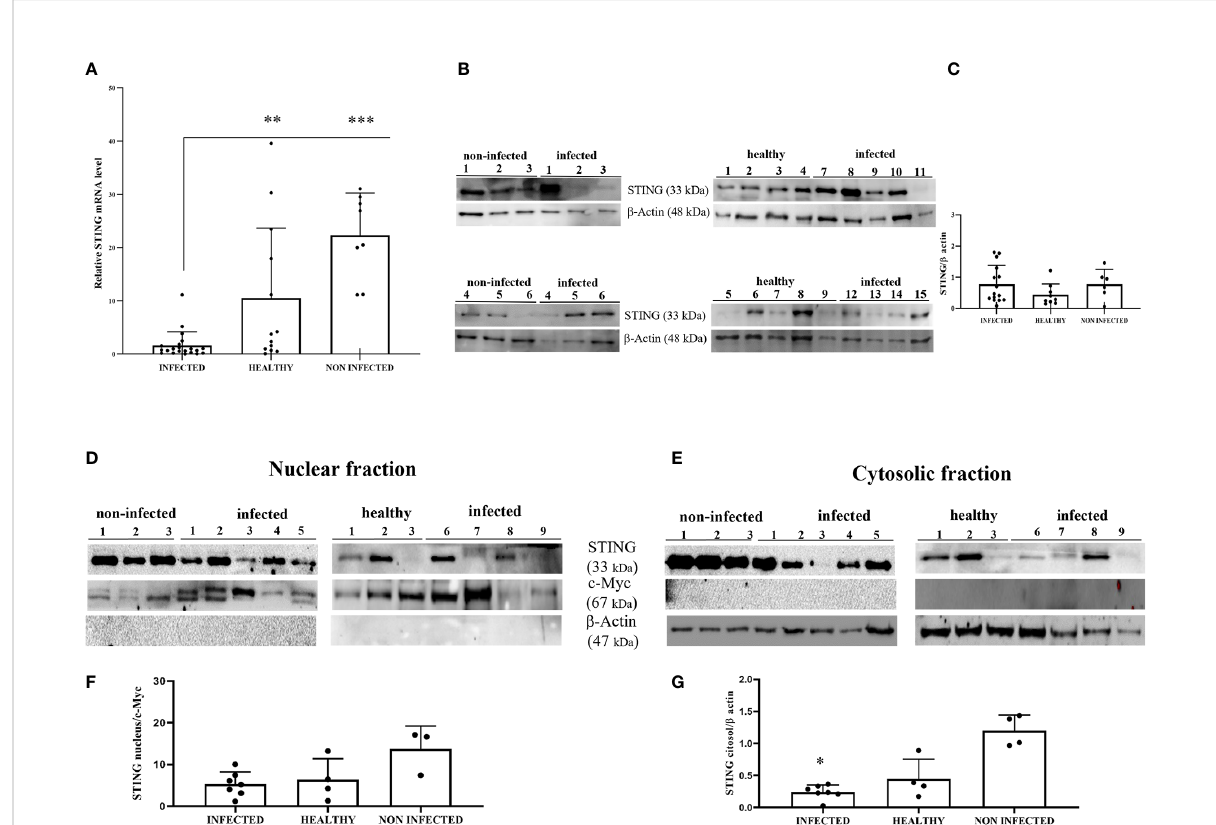
FIGURE 3 (A) RT-qPCR analysis of STING mRNA levels in infected, non-infected, and healthy bladder samples, respectively. STING mRNA expression was signi fi cantly reduced in infected bladder compared with both non-infected and healthy bladder samples (***p ≤ 0.001; **p ≤ 0.01);. (B) Western blot analysis of STING in infected, non-infected, and healthy bladder samples. (C) Densitometric analysis was performed by comparing the protein expression levels of total STING with b -actin. (D, E) STING western blot of nuclear and cytosolic fractions of infected, non-infected, and healthy bladder tissues. (F, G) cMyc and b -actin were used to verify selectivity of the extracts and perform the densitometric analysis. There was no statistically signi fi cant variation in STING protein levels in total and in differentiated fractions in infected bladder tissue compared with both non-infected and healthy bladder samples. Plots present measurements from each sample performed in